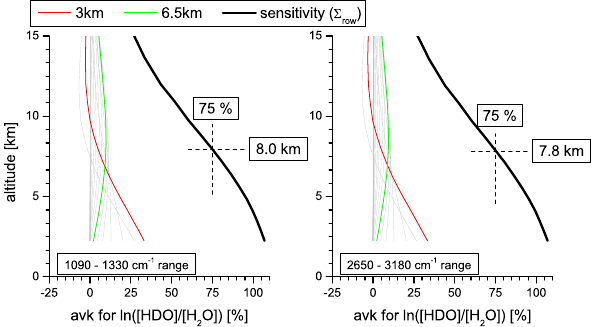
Fig. 6. Averaging kernels for δ D (expressed as ln [ HDO ] [ H 2 O ] ) for the mid-infrared spectral regions. Grey lines: kernels for all atmo- spheric model grid levels; Red and green lines: kernels for the 3 and 6 . 5 km grid level (representative for the lower and middle/upper tro- posphere); Thick black line: Sensitivity (sum along the row of the averaging kernel matrix). Table 1. Typical degree of freedoms (dof) with respect to water vapour for the measurements in the different spectral regions. spectral range